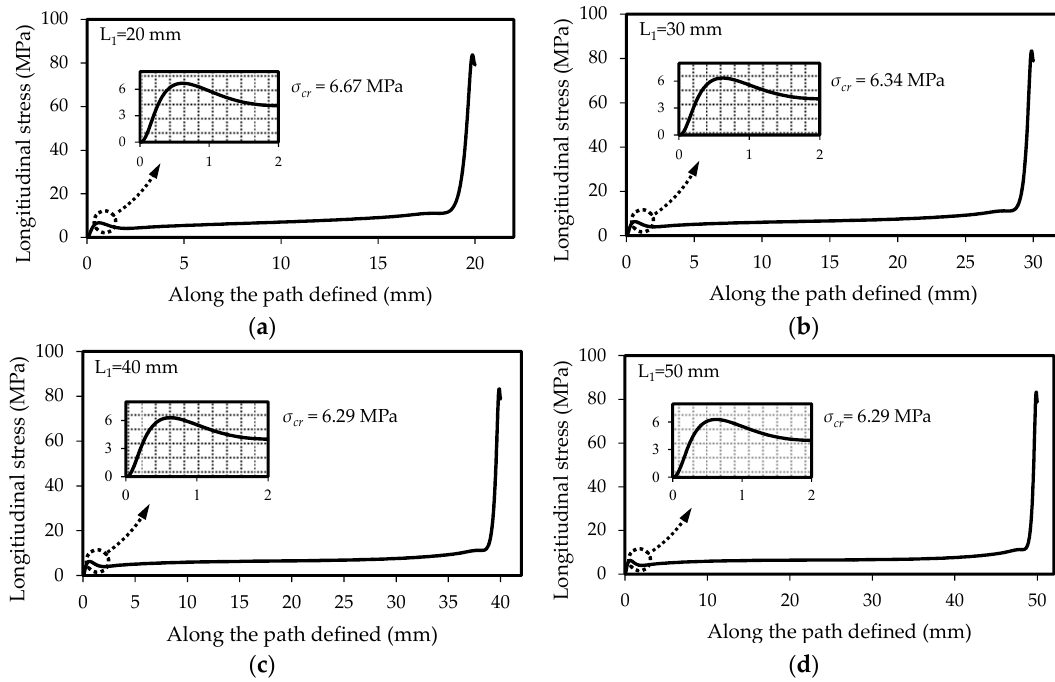
Figure 7. Longitudinal stress distribution along the path defined in the mid-plane of the adhesive layer for the present experimental series—( a ) L 1 = 20 mm; ( b ) L 1 = 30 mm; ( c ) L 1 = 40 mm; ( d ) L 1 = 50 mm (applied stress for all the specimens: 1000 MPa).